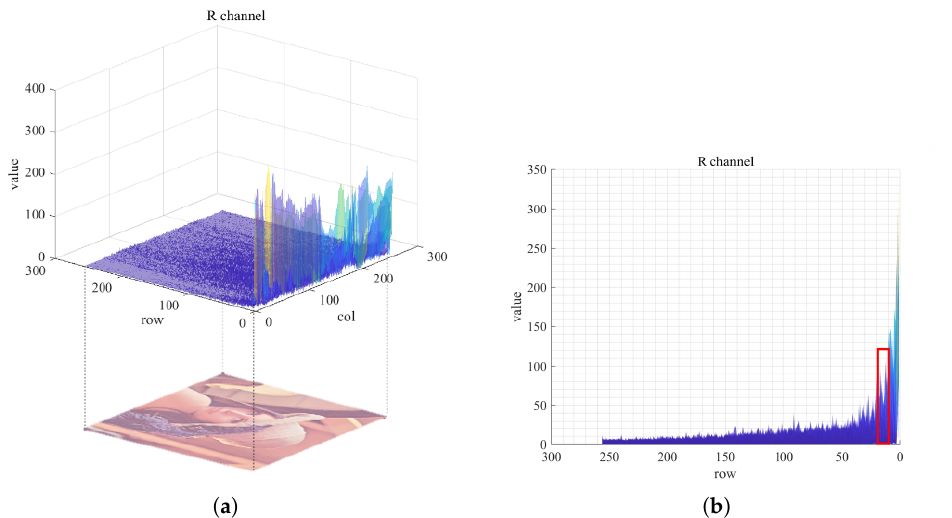
Figure 6. Actual noise observed in a D2C link. ( a ) Noise expressed as a 3D function. ( b ) Noise as seen from the row axis. The red box indicates the rows where the data are